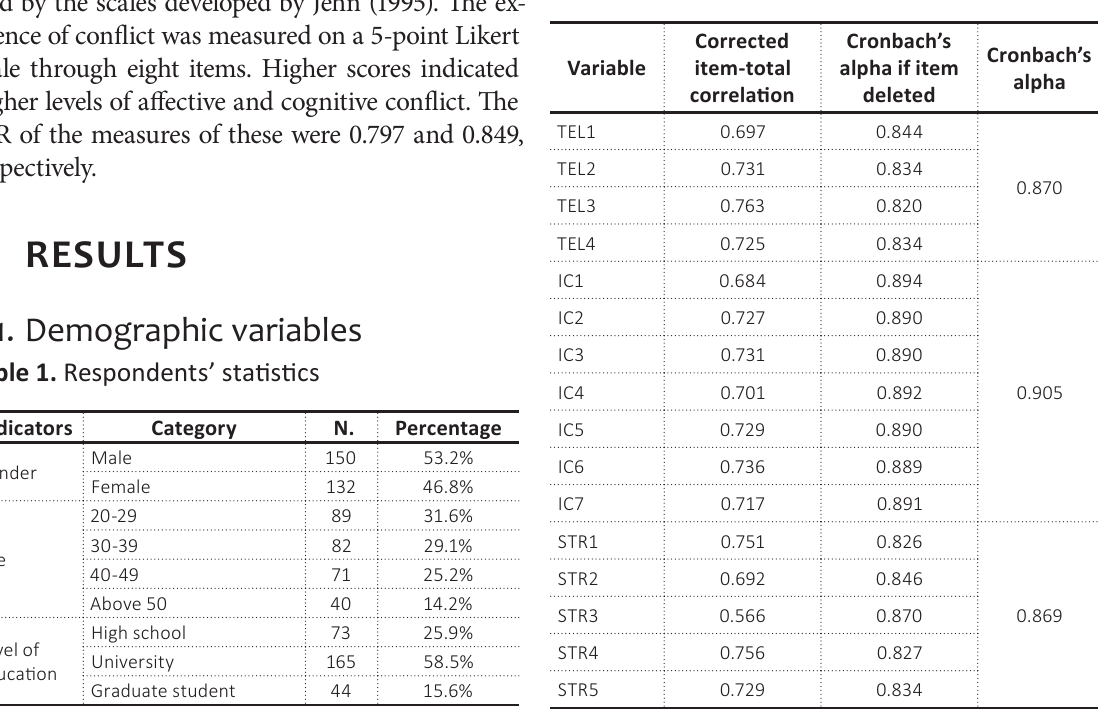
Table 2. Analysis of